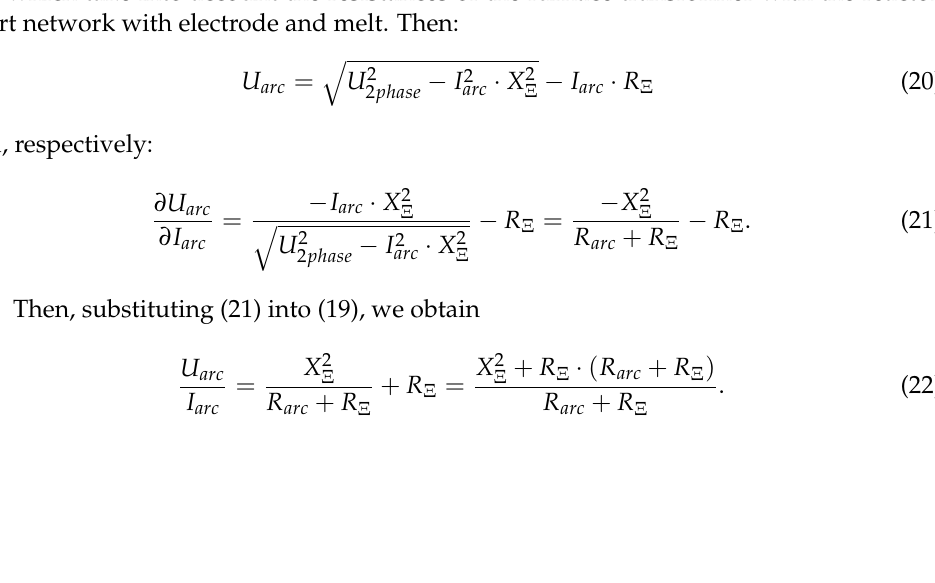
Figure 9. Structural–functional diagram of the electrode movement system.